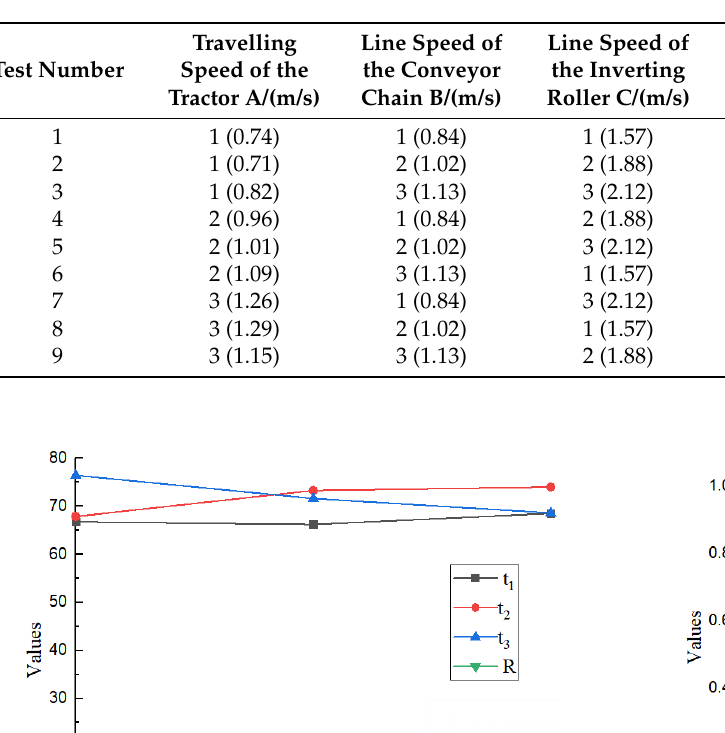
Table 6. Experimental design and results of pressed vines.